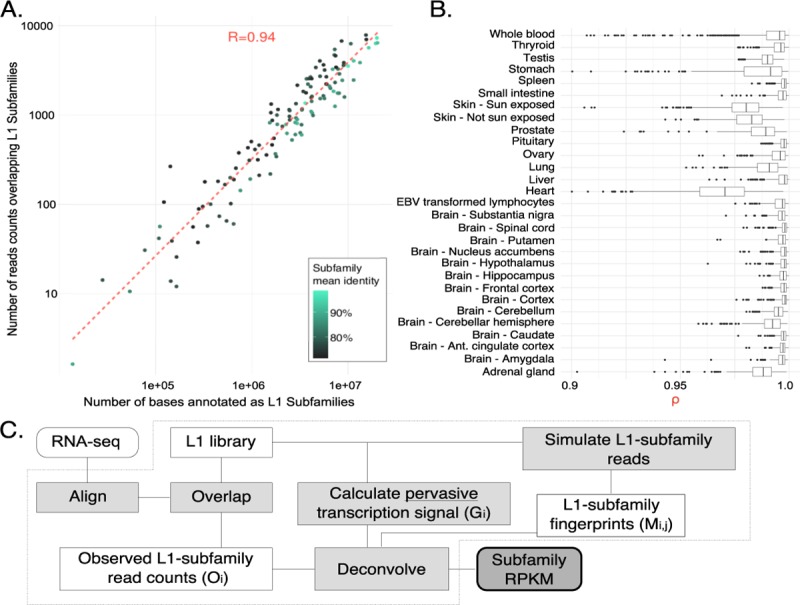
As pervasive transcription is a major factor leading to reads mapping to L1 instances, TeXP functions as an approach to decouple pervasive transcription from autonomous transcription.(A) The number of reads mapped to LINE-1 subfamilies is proportional to the number of bases annotated as the subfamily for most RNA sequencing experiments. Point colors represent the subfamily average identity to LINE-1 consensus. (B) Healthy human tissues show varied distributions of the genomic-transcriptomic correlation. (C) Pipeline chart describes the TeXP approach.